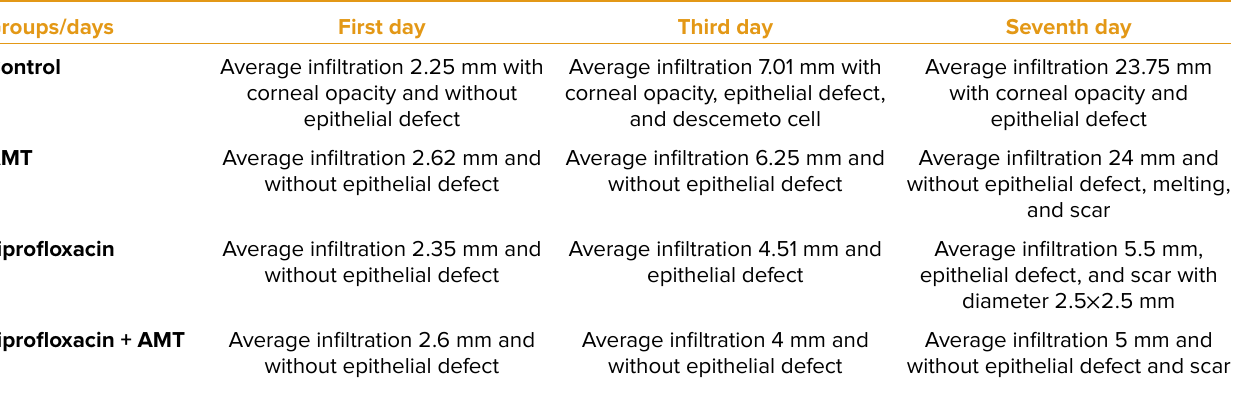
Figure 1. Cornea infiltration of the four groups of experiment. (A: Control group; B: AMT group; C: ciprofloxacin; D: AMT + ciprofloxacin).